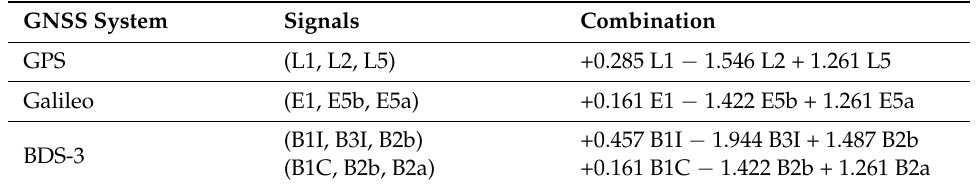
Table 4. Triple-frequency carrier phase combinations for analysis of carrier phase noise and multipath errors, as well as the inter-frequency clock bias (IFCB) variations.